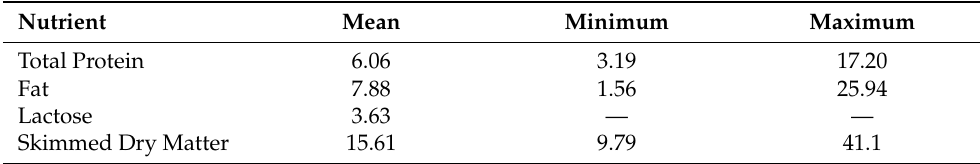
Table 10. Chemical composition of camel colostrum (g/100